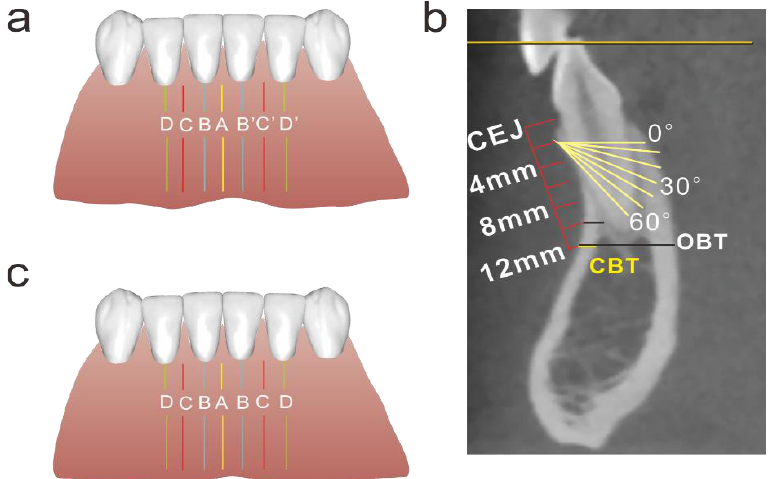
Figure 1. Schematic diagram of measuring method. ( a ) Seven insertion locations, A: the section bisecting the distance between two lower central incisors; B: labial to the middle of right central incisor; C: the section bisecting the distance between the right central and lateral incisors; D: labial to the middle of right lateral incisor; B’, C’, D’ represent the contralateral sites of B, C, D respectively. ( b ) Measurements of overall bone thickness (OBT) and cortical bone thickness (CBT) at different insertion heights and angles. ( c ) Four insertion locations after left- and right-side data were combined. Both overall bone thickness (OBT) and cortical bone thickness (CBT) were